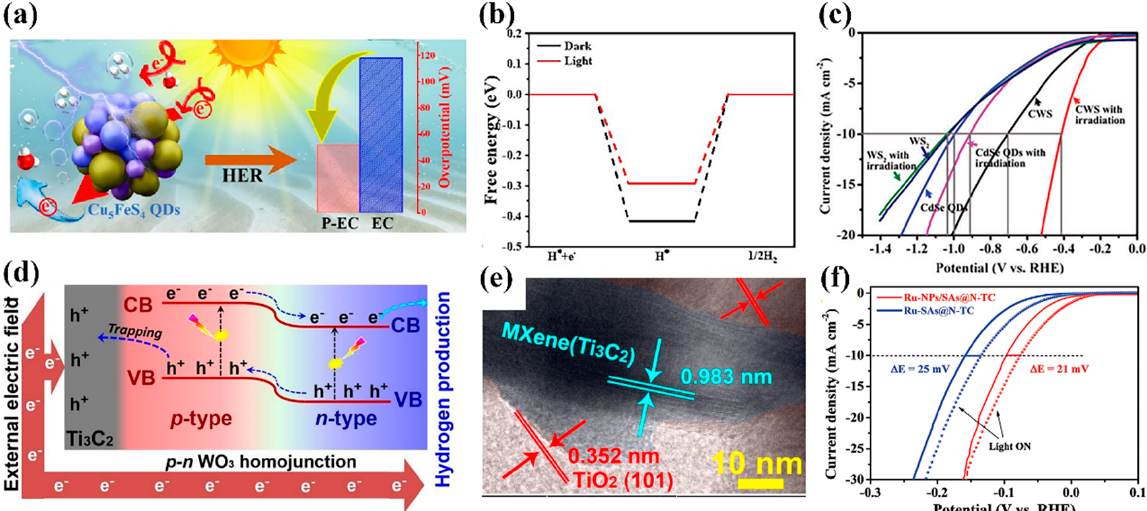
Figure 3. ( a ) Schematic diagram of the photo-assisted hydrogen evolution process for Cu 5 FeS 4 QDs and ( b ) H* adsorption free energy of Cu 5 FeS 4 QDs in dark and light conditions, respectively. Adapted with permission from ref. [46]. Copyright 2023, Royal Society of Chemistry. ( c ) LSV curves of CdSe QDs/WS 2 . Adapted with permission from ref. [69]. Copyright 2018, Royal Society of Chemistry. ( d ) Schematic diagram of the charge transfer process in a p-n WO 3 homojunction under light irradiation. Adapted with permission from ref. [72]. Copyright 2019, Royal Society of Chemistry. ( e ) HRTEM image of P-TiO 2 @MXene. Adapted with permission from ref. [73]. Copyright 2021,